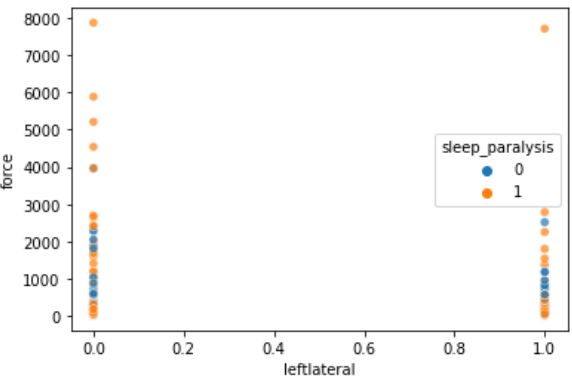
Figure 15: Left Lateral vs Sleep paralysis